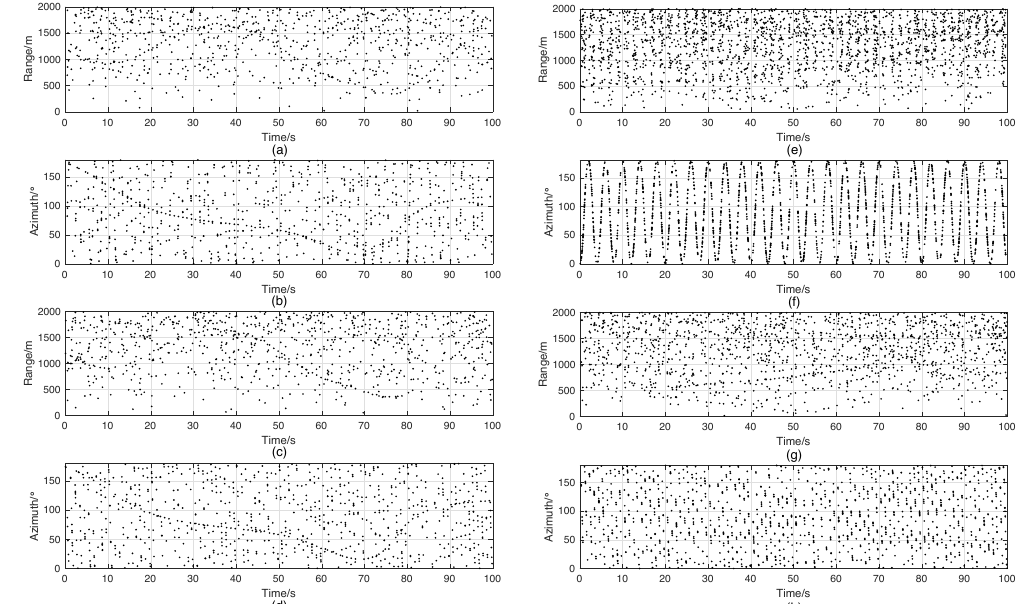
Figure 2. Measurements of one trail. ( a ) Range components of the measurements in Scenario 1. ( b ) Azimuth components of the measurements in Scenario 1. ( c ) Range components of the measurements in Scenario 2. ( d ) Azimuth components of the measurements in Scenario 2. ( e ) Range components of the measurements